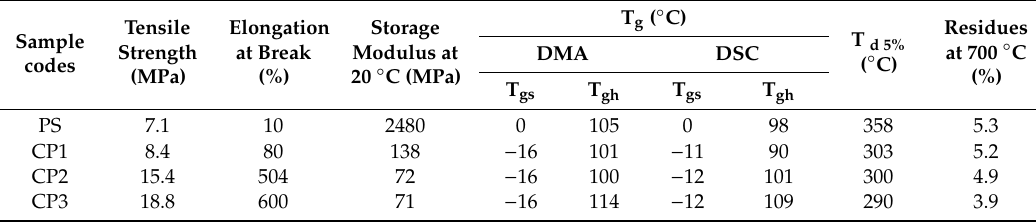
Table 2. Summary of tensile properties, DMA, and TGA data of